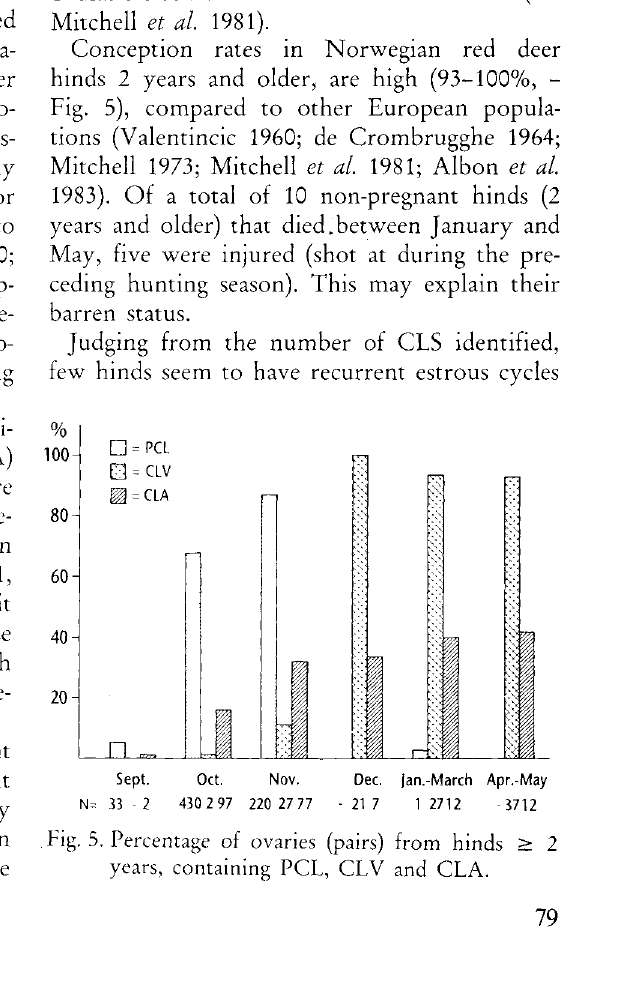
Fig. 4. Relationship between the diameter of CR in ovaries from lactating hinds and dressed weight of their calves.